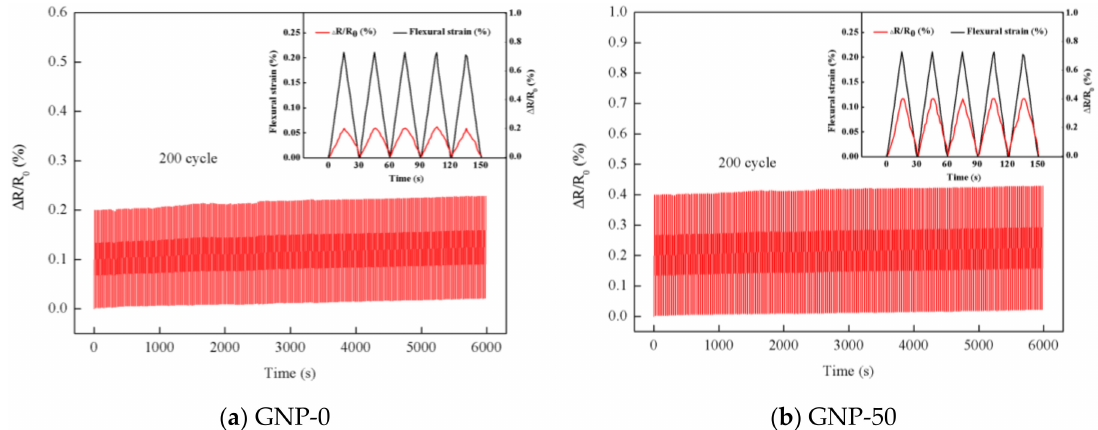
Figure 10. Normalized resistance change and mechanical strain of the hybrid film under cyclic loading-unloading test ( a ) 0 wt.% GNP-0 ( b ) 50 wt.%